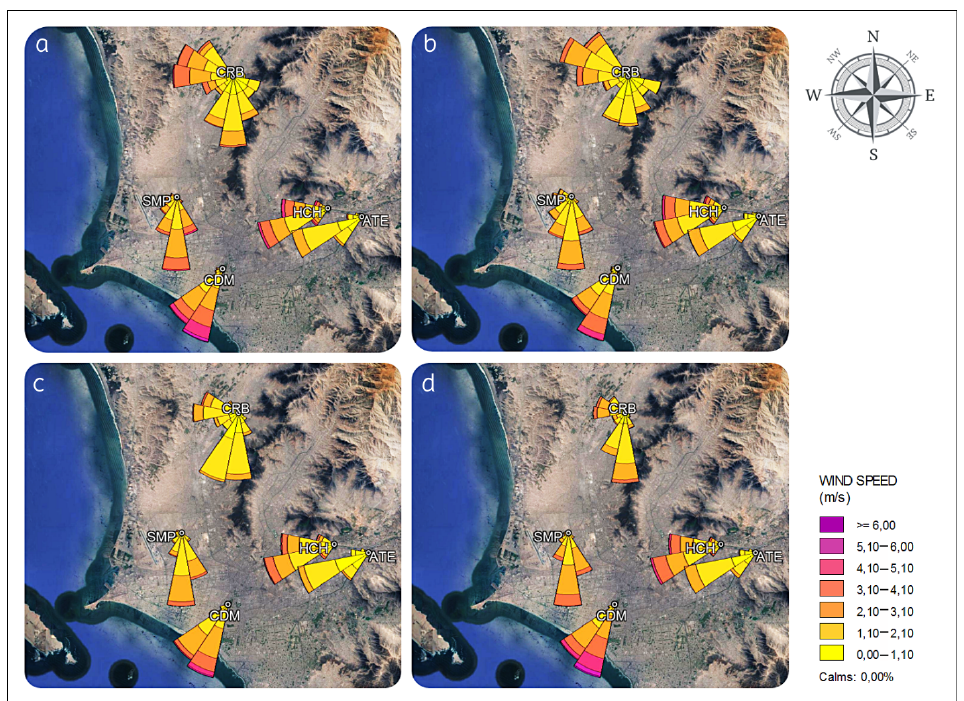
Figure 10. Geolocated wind roses of five air quality monitoring stations for each season in ( a ) summer, ( b ) fall, ( c ) winter, ( d ) spring of the year 2018.